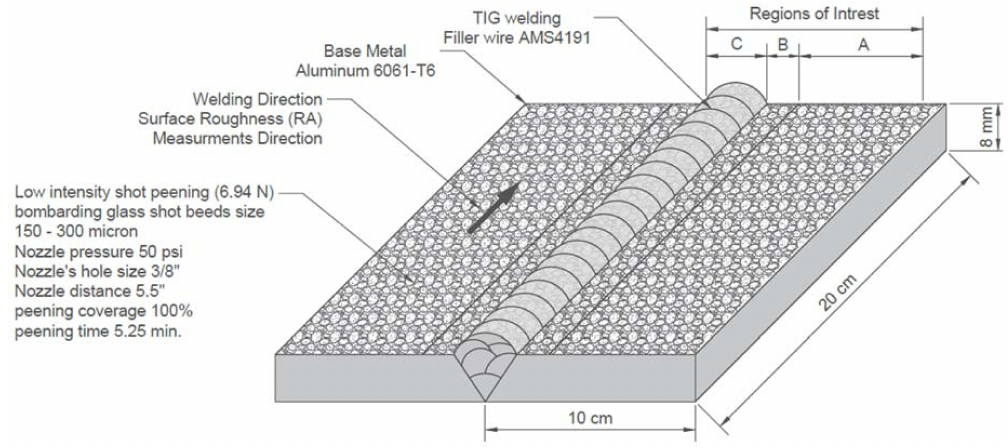
Figure 2. Geometry of Al6061-T6 low-intensity shot-peened, TIG-welded specimen.